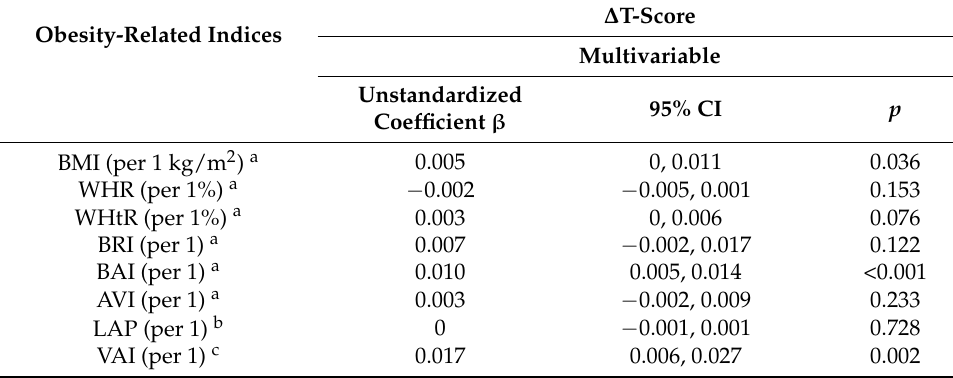
Table 6. Determinants of ∆ T-score using multivariable linear regression